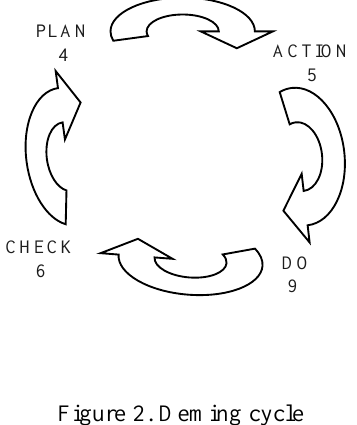
Figure 2. Deming